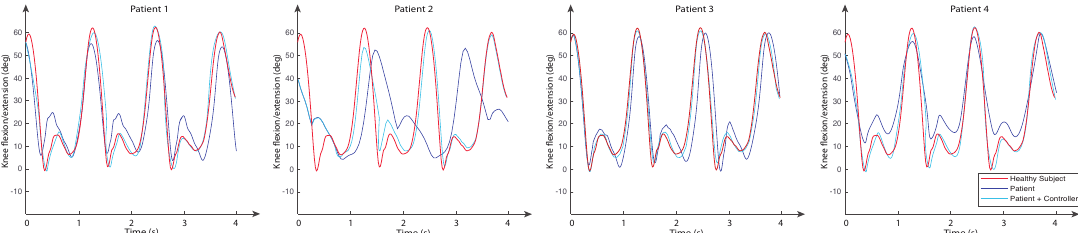
Figure 13. Knee flexion/extension angles for a normal subject (reference signal) and four subjects with multiple sclerosis for both open loop and using the PD adaptive